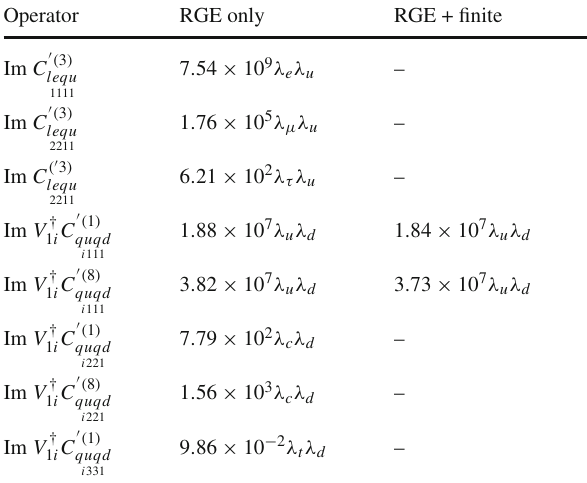
Table8 UpperboundsontheWilsoncoefficientsofthe4-fermionoper- atorsassuming (cid:2) = 5TeVandnofurtherassumptions.Noticethateach entry of the table corresponds to one the mass-basis Wilson coefficients that enter the expression of the neutron EDM. For all of them, however, the corresponding C (cid:4) Wilson coefficients in the up-quark gauge basis are indicated, together with the CKM transformations needed to the change of basis. Wherever the phase of the CKM matrix enters in the bound, the bound is given on the real instead of the imaginary part. If the summation over the CKM elements gives a symmetric contribution ( 1 , 8 ) for the operator O , they have to be ignored because they are CP qd even and cannot give rise to an EDM. Note also, that the ‘RGE + finite’ (cid:4) ( 1 , 8 ) C column for V † 1 i